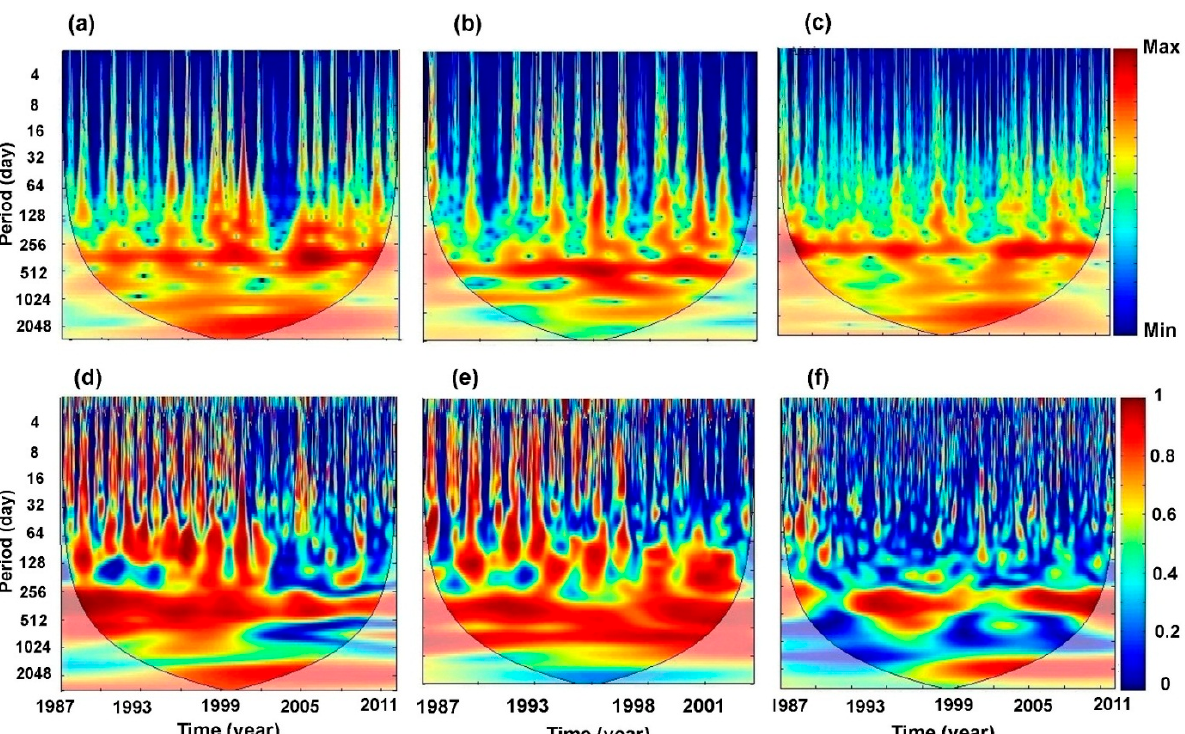
Figure 9. Cross wavelet spectra (XWT) of daily rainfall and streamflow of ( a ) Acsif N’Boubhir, ( b ) Sebaou Rabta, and ( c ) Aïssi sub-basins and wavelet coherence spectra (WCT) of daily rainfall and streamflow of ( d ) Acsif N’Boubhir, ( e ) Sebaou Rabta, and ( f ) Aïssi sub-basins (the dark line denotes the ‘’cone of influence’’, where edge effects become important).